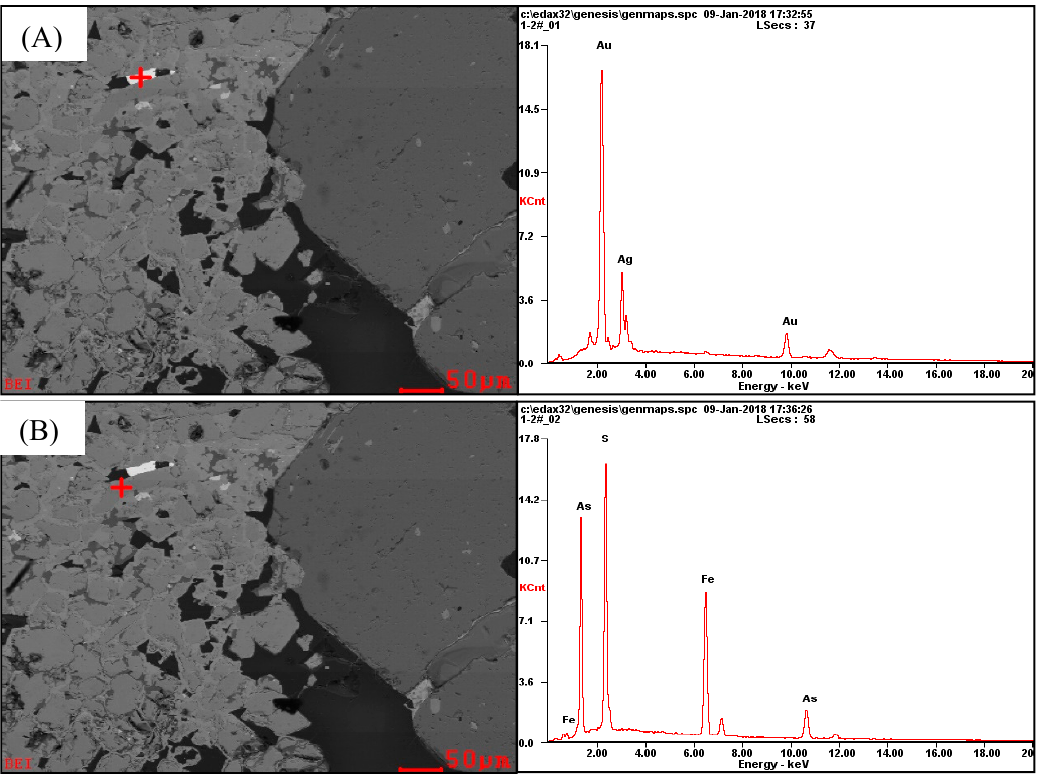
Figure 5. SEM images and EDS analysis of intergranular gold in arsenopyrite: ( A ) enclosing gold in arsenopyrite; ( B ) arsenopyrite.